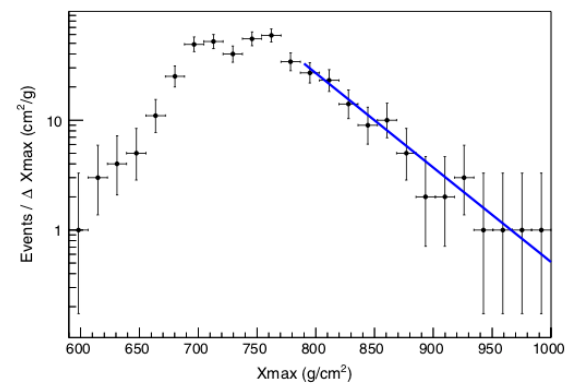
pomeron exchange model while describing the Tevatron data correctly is not consistent with the Unitarity constraint ([35,40]). Here the unitarity constraint is shown by solid grey shaded area in Fig. 8. A more recent prediction is the BHS fit [5]. It is consistent with unitarity while using a QCD inspired fit to the pp and ¯ pp data from the Tevatron. The dashed line in Fig. 8 shows the BHS prediction. Here